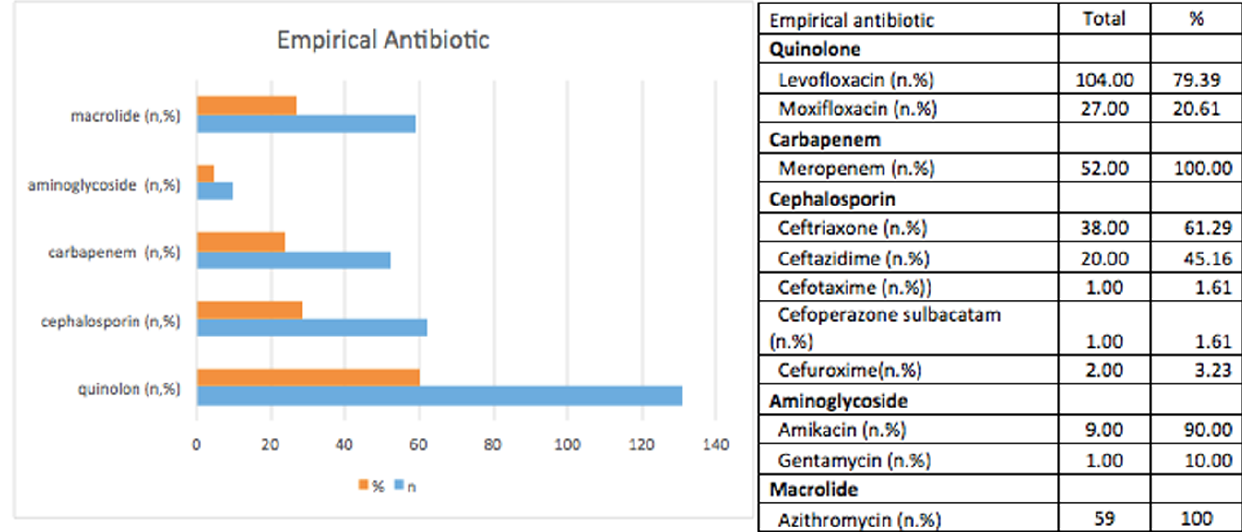
Figure 1. The empirical antibiotic use in study